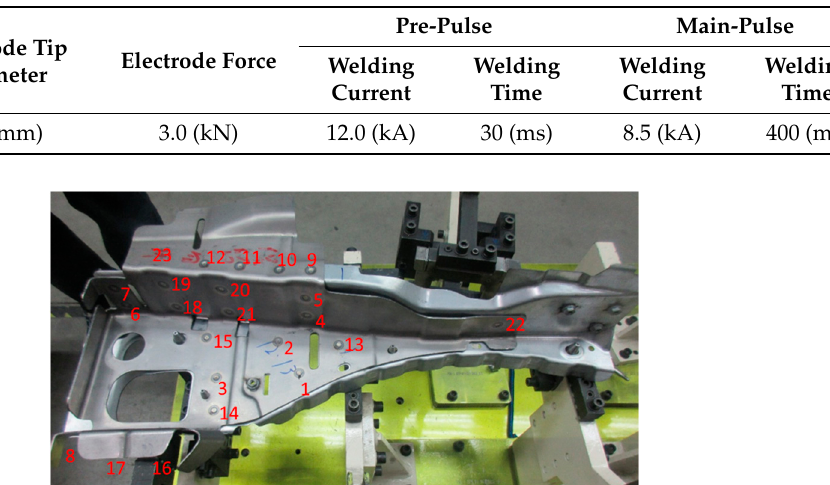
Table 2. Welding conditions.